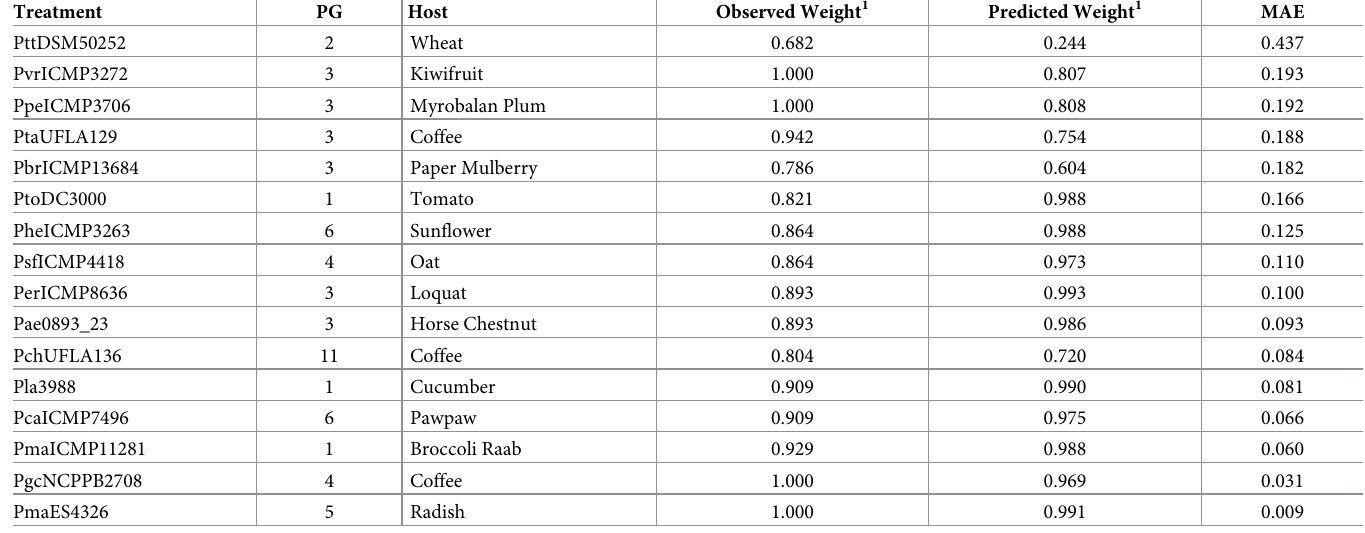
Table 3. Model Functional